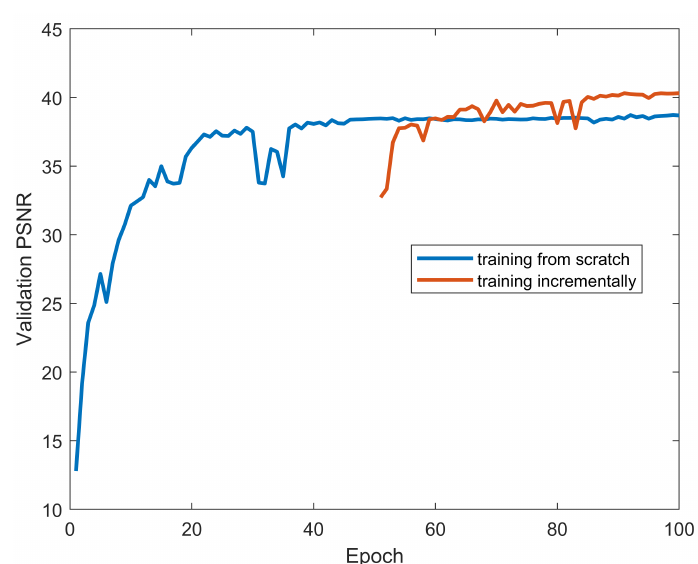
Figure 9. PSNR comparison of different training